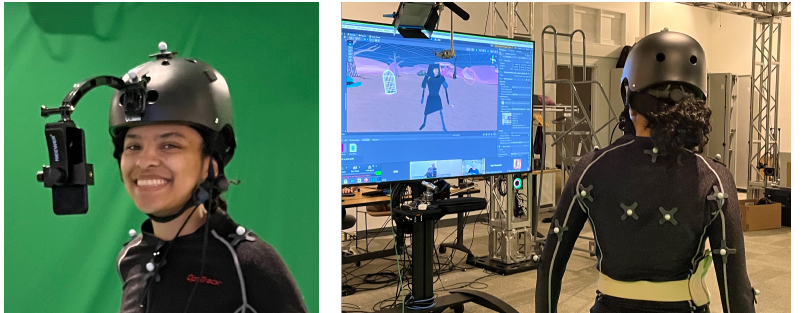
Figure 9. HoloKinect components used in a live theater production by the UIXR Studio at the University of Iowa. An iPhone TrueDepth sensor is used to capture RGB-D data of a performer’s face. This RGB-D data is encoded and compressed as detailed in this paper, transmitted by Agora, and finally processed by the HoloKinect pipeline on the receiving device. The reconstructed facial mesh is registered onto a digital avatar, which is controlled by the performer via an OptiTrack motion capture setup. Audience members will participate in this production remotely in Meta Quest 2 virtual reality